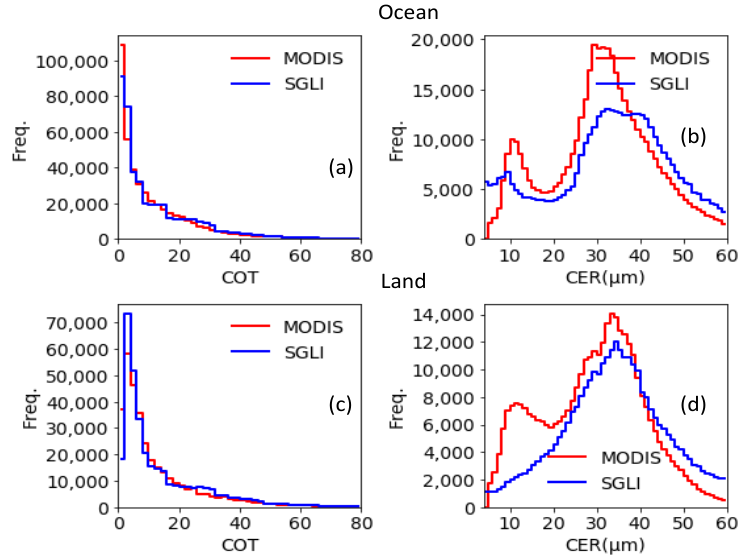
Figure 4. Frequencies of ( a ) COT over ocean, ( b ) CER over ocean, ( c ) COT over land, and ( d ) CER over land for MODIS (red) and SGLI (blue) for ice cloud pixels.